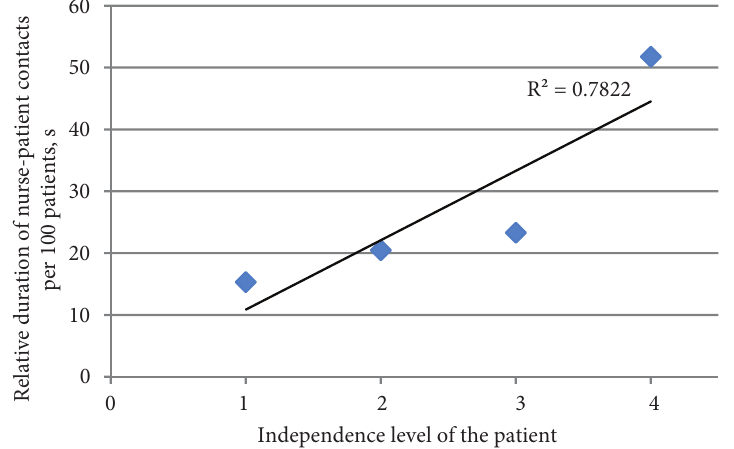
Figure 2. The relationship between the amount of time spent to direct nursing care, based on the relative duration of nurse-patient contacts (per 100 patients) and patients’ level of independence in medical units of a